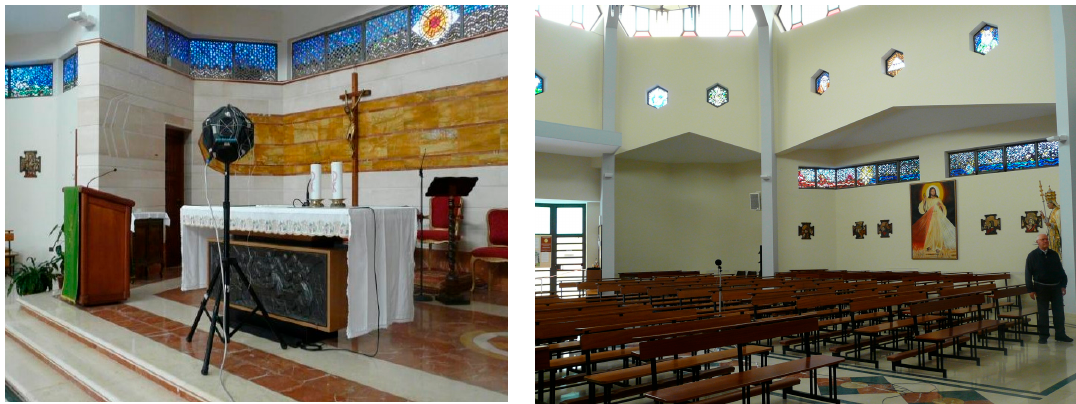
Figure 4. Sound source and microphone during the acoustic measurements.